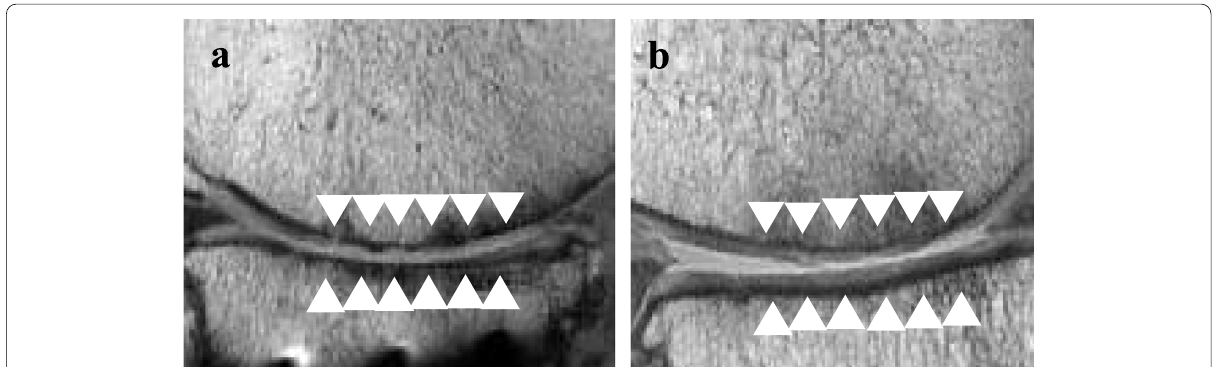
Fig. 4 a Sagittal images of the knee at three months postoperatively. The filling of the defect was incomplete, the repair tissue surface was damaged, the subchondral bone was not intact (arrows) and the MOCART score was 40 points. b Follow-up sagittal images at one year postoperatively. Incomplete filling of the defect along with incomplete integration with the adjacent native cartilage (arrows) was observed and the MOCART score was 60